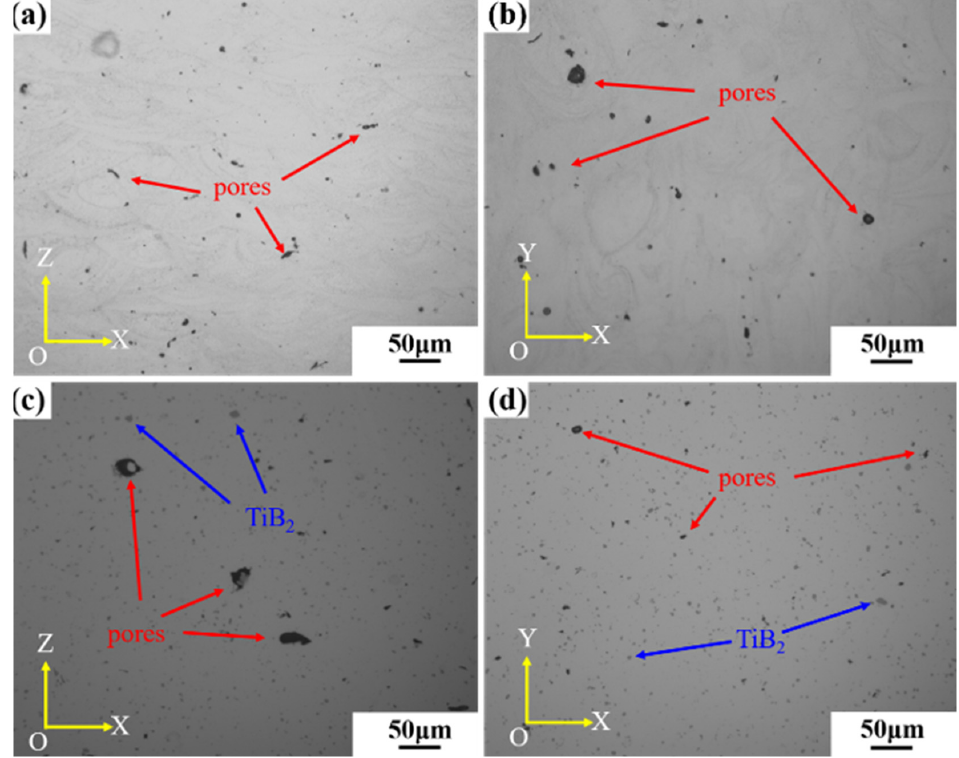
Figure 3. Metallography of SLM formed as-printed specimen: ( a ) vertical plane of AlZnMgCu(Sc,Zr) alloy, ( b ) horizontal plane of AlZnMgCu(Sc,Zr) alloy, ( c ) horizontal plane of TiB 2 /AlZnMgCu(Sc,Zr) composite and ( d ) horizontal plane of TiB 2 /AlZnMgCu(Sc,Zr) composite. The densification of the composites is 99.67%, tested by electronic solid densitometer. Compared with the 98.7% densification of AlZnMgCu(Sc,Zr) sample fabricated by the op-